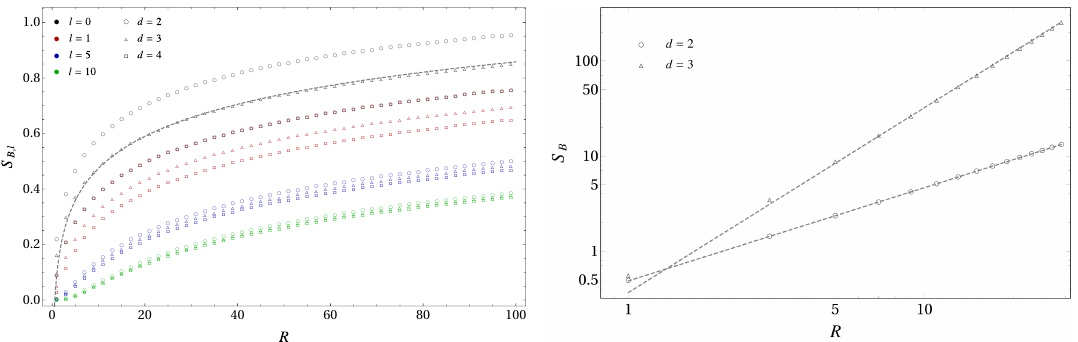
Figure 7. The quantity S B,l (left panel) and the entanglement entropy S B (right panel), defined in (3.30), when ω = 0 and for some values of d